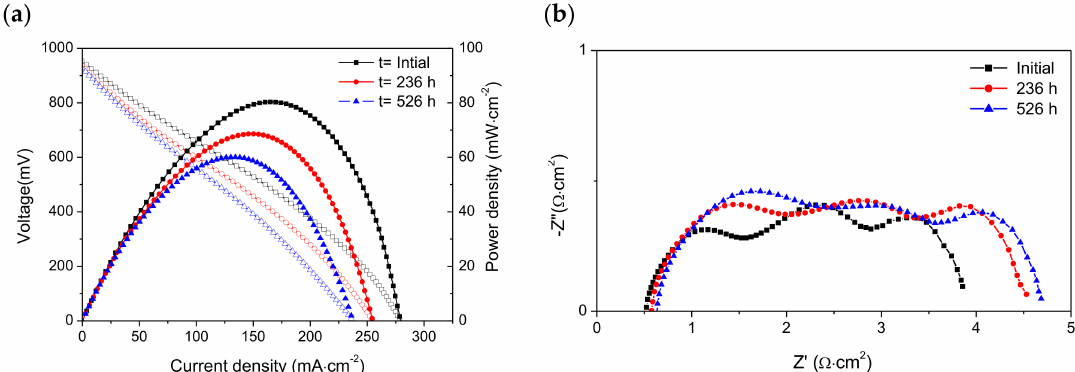
Figure 6. ( a ) I-V curves and ( b ) impedance spectra of the cell (Ni-CYSZ / YSZ / LSM) at 850 ◦ C in dry CH 4 before and after long-term stability testing for 236 h and 526